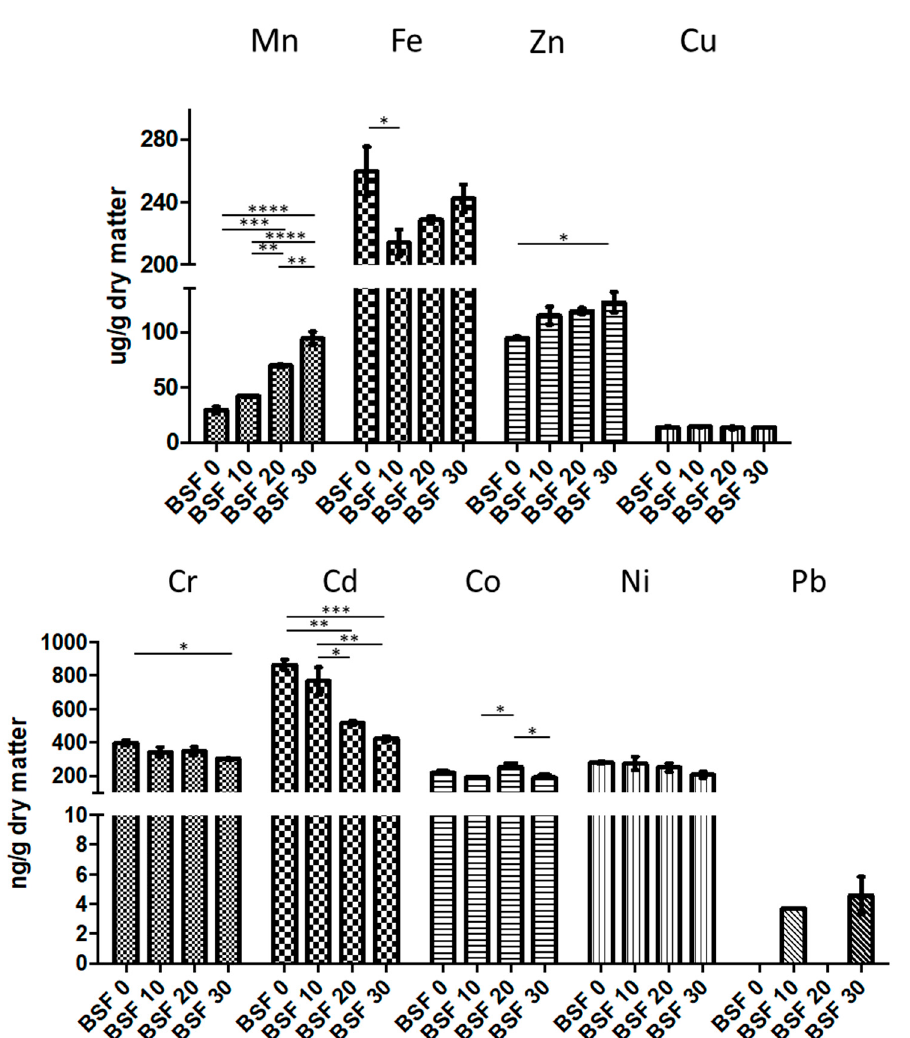
Figure 7. Mineral levels in the fish diets (one-way ANOVA and Tukey’s post-hoc test (GraphPad Prism5).